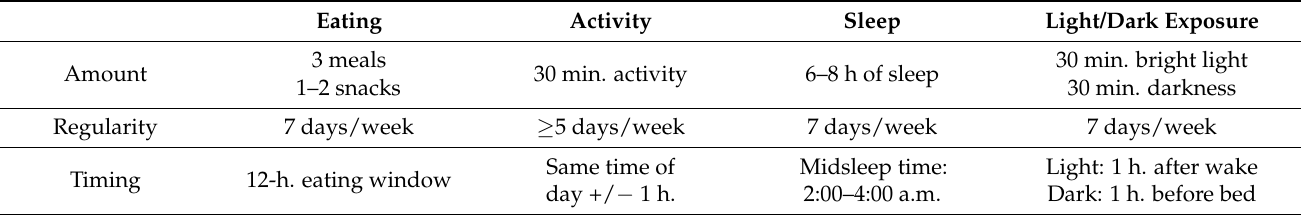
Table 4. The ART of